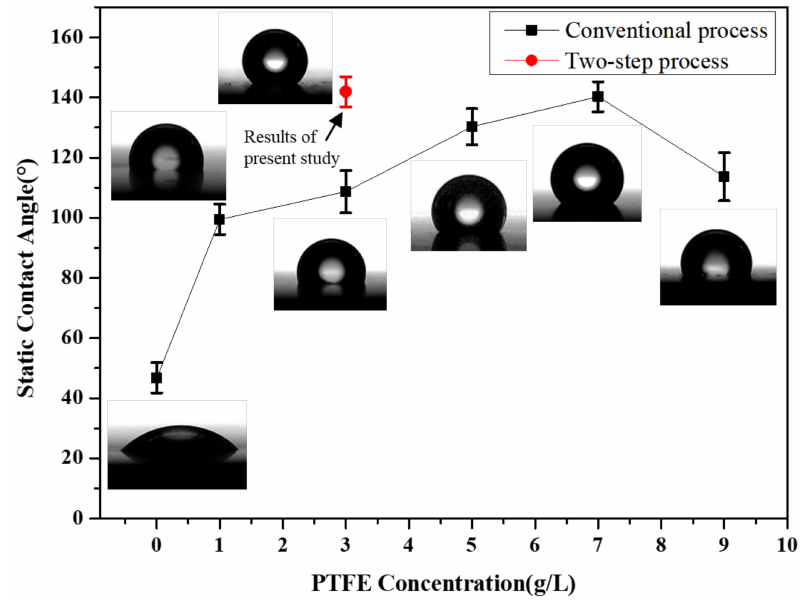
Figure 7. Static contact angle after PTFE precipitation and at different concentrations of